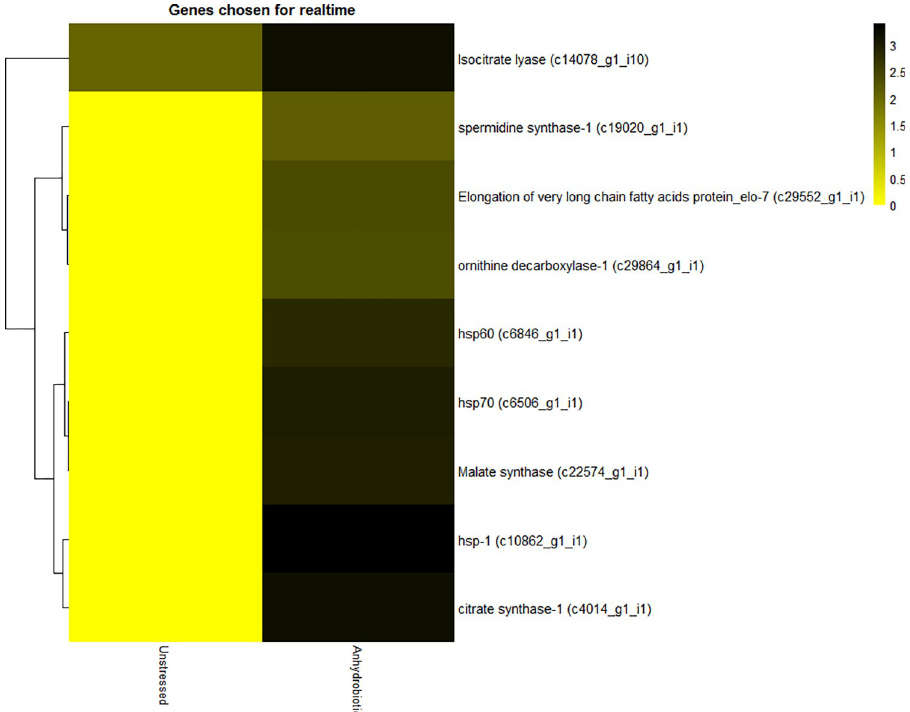
Fig 8. Expression profile of genes selected for qRT-PCR study based on FPKM value (values are log transformed).